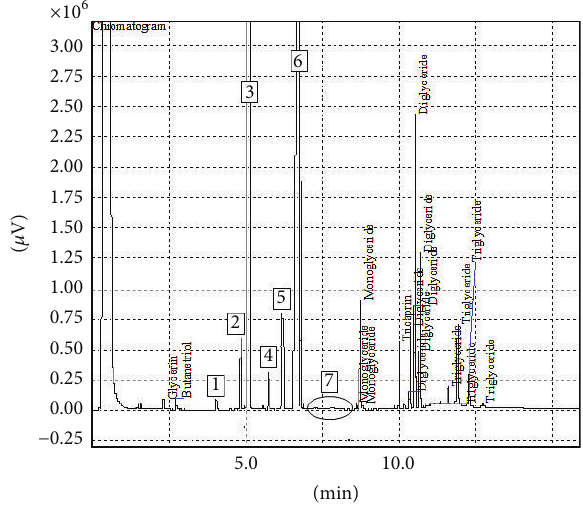
Figure 13: Methyl ester content in CCO.